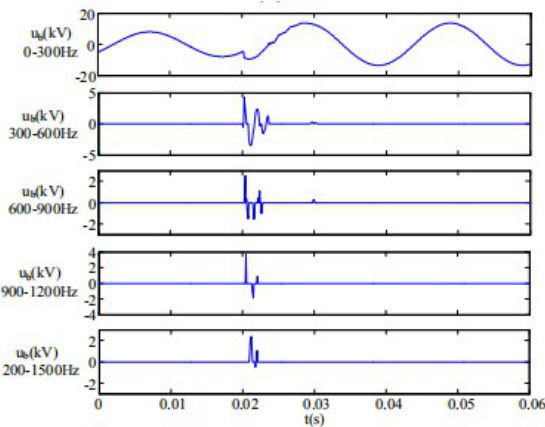
Fig. 3. Components of b-phase voltage waveform of AG fault in line 1 in five sub-frequency bands by using HHT band-pass filtering method